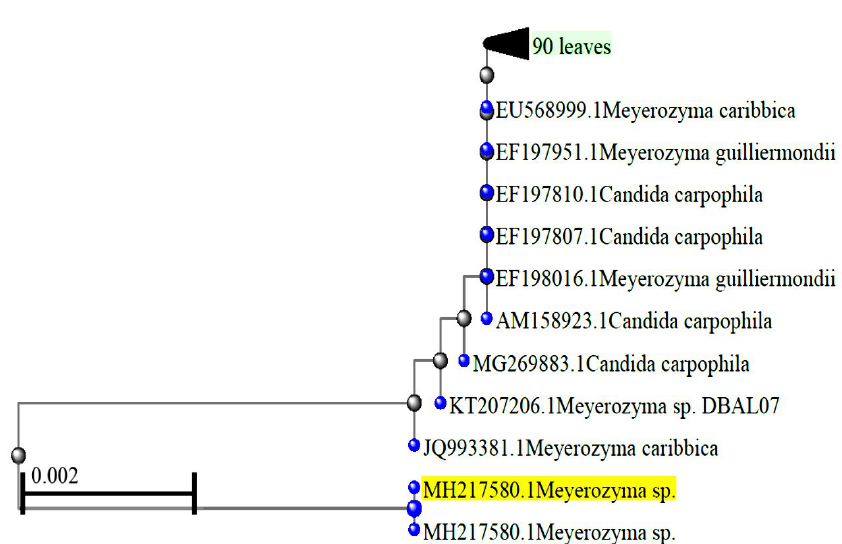
Fig. 3 . Phylogenetic tree of Meyerozyma sp. VITPCT75 (MH217580)